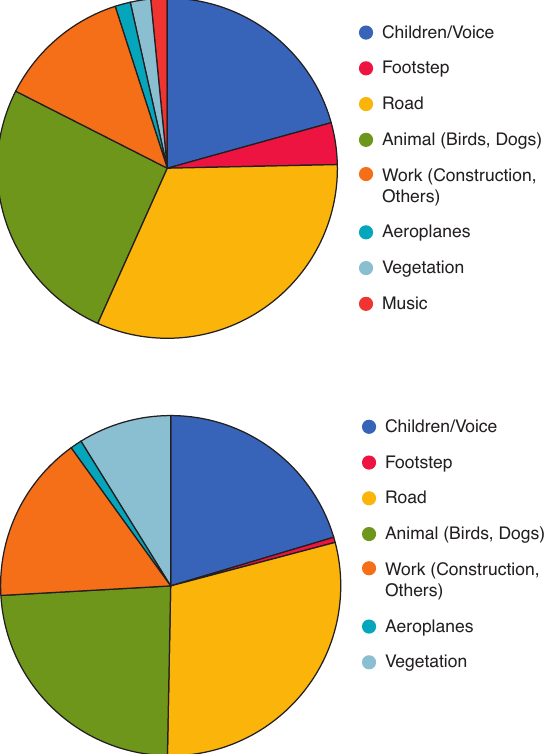
Main noise sources perceived during the measurements under the state of emergency.